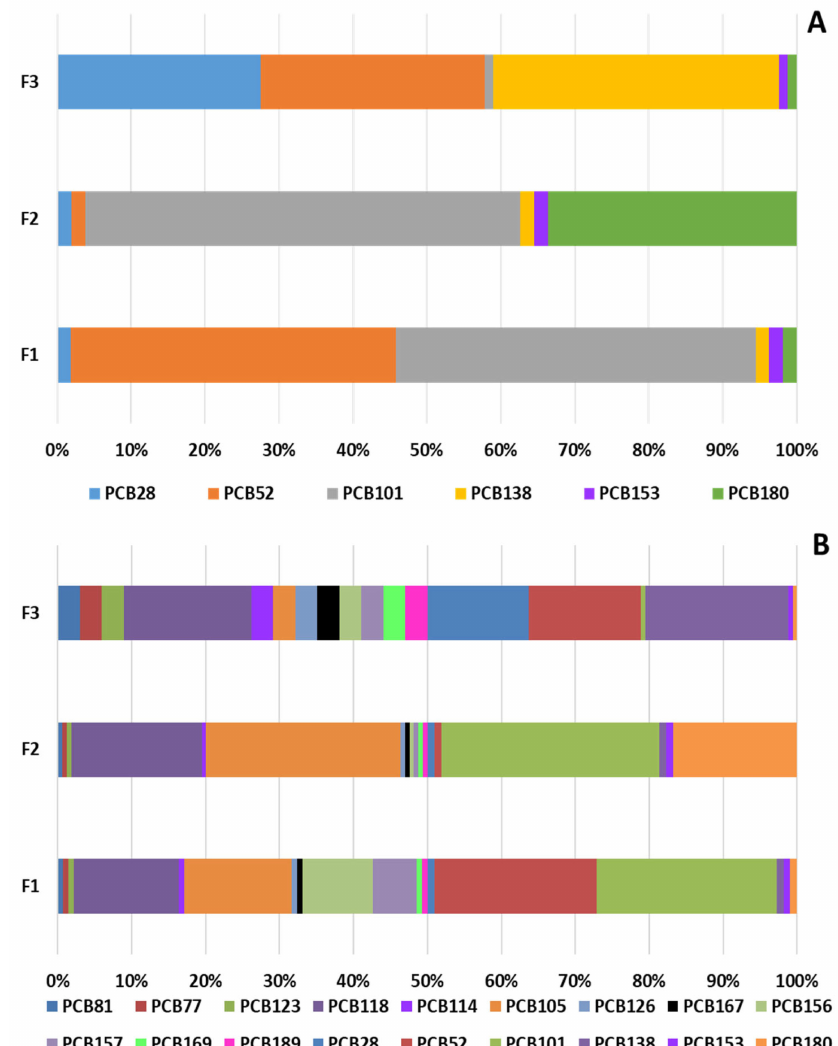
Figure 4. Relative abundances of IPCBs ( A ) and DLPCBs ( B